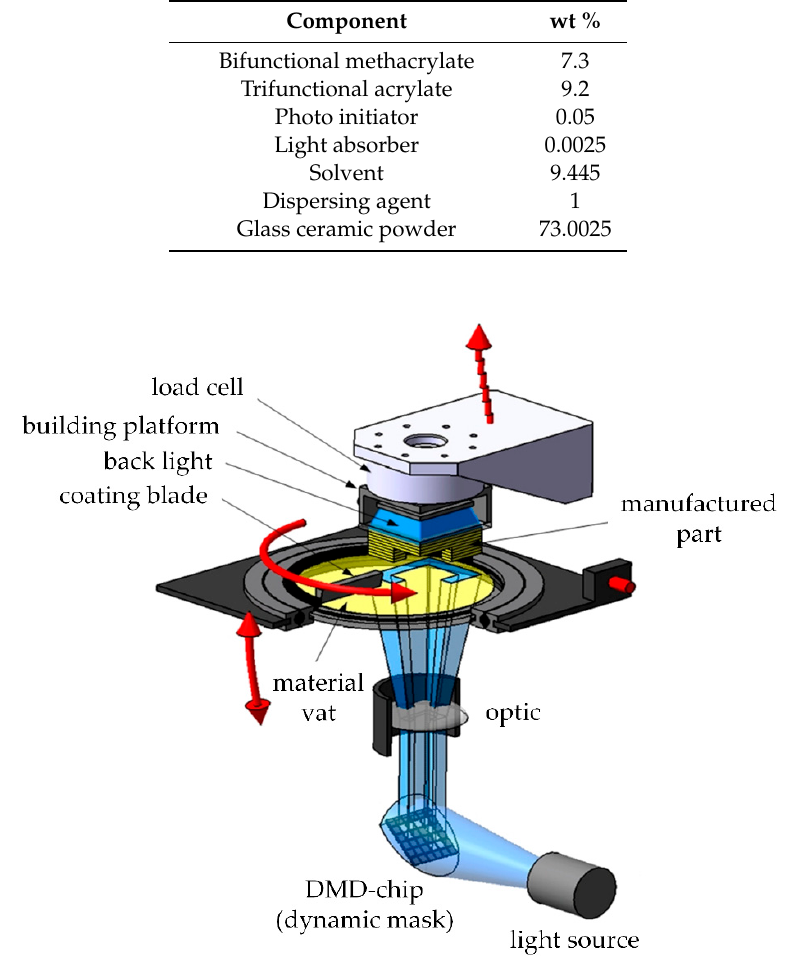
Figure 1. DLP system, schematic setup (modified [19]).